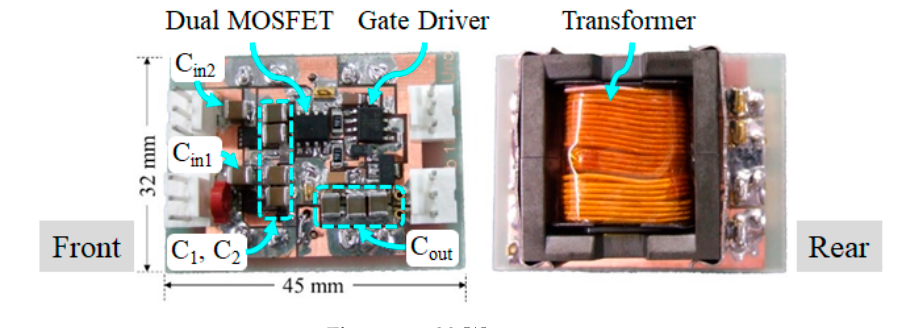
Figure 13. 30-W prototype. Table 2. Circuit parts used for the